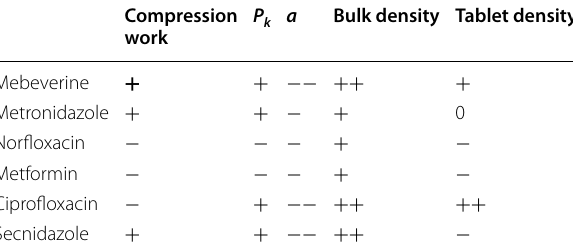
Table 3 Notations of the increase or decrease of the compression work, Kawakita parameters ( P and tablet hardness before and after compaction marked by the “ ” and the “–” signs. The “ + indicates large decrease. “0” indicates no